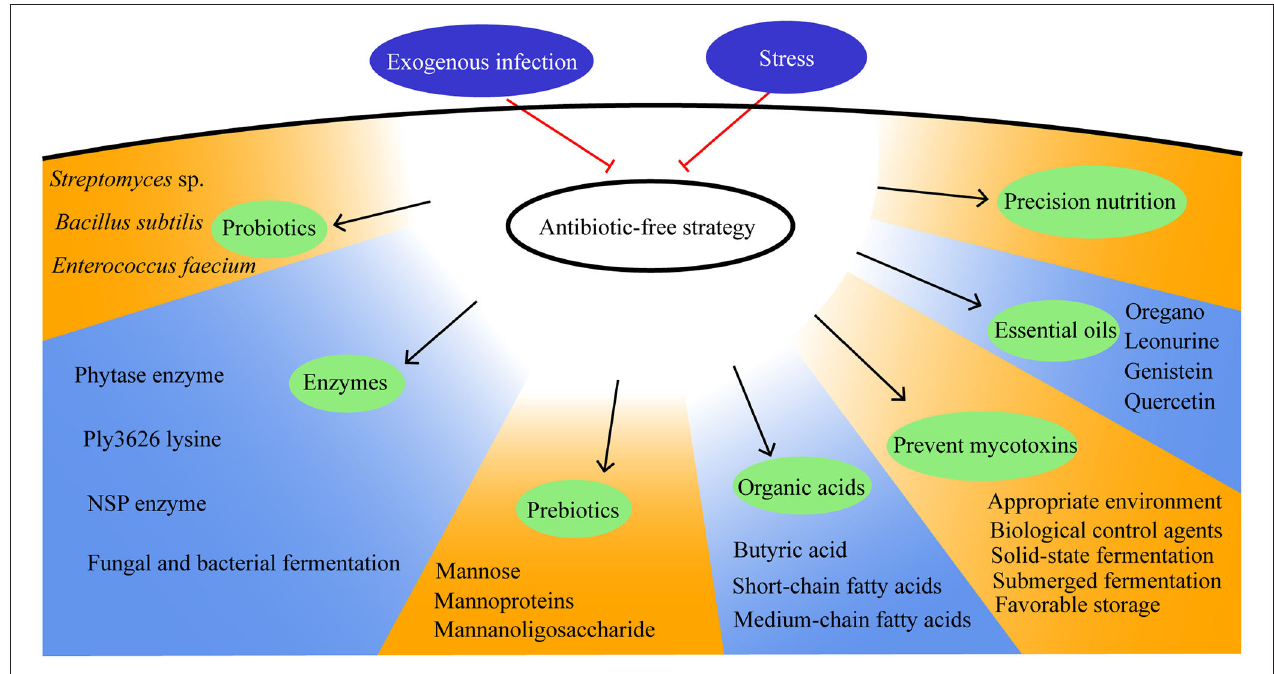
FIGURE 4 | Antibiotic-free management strategies in